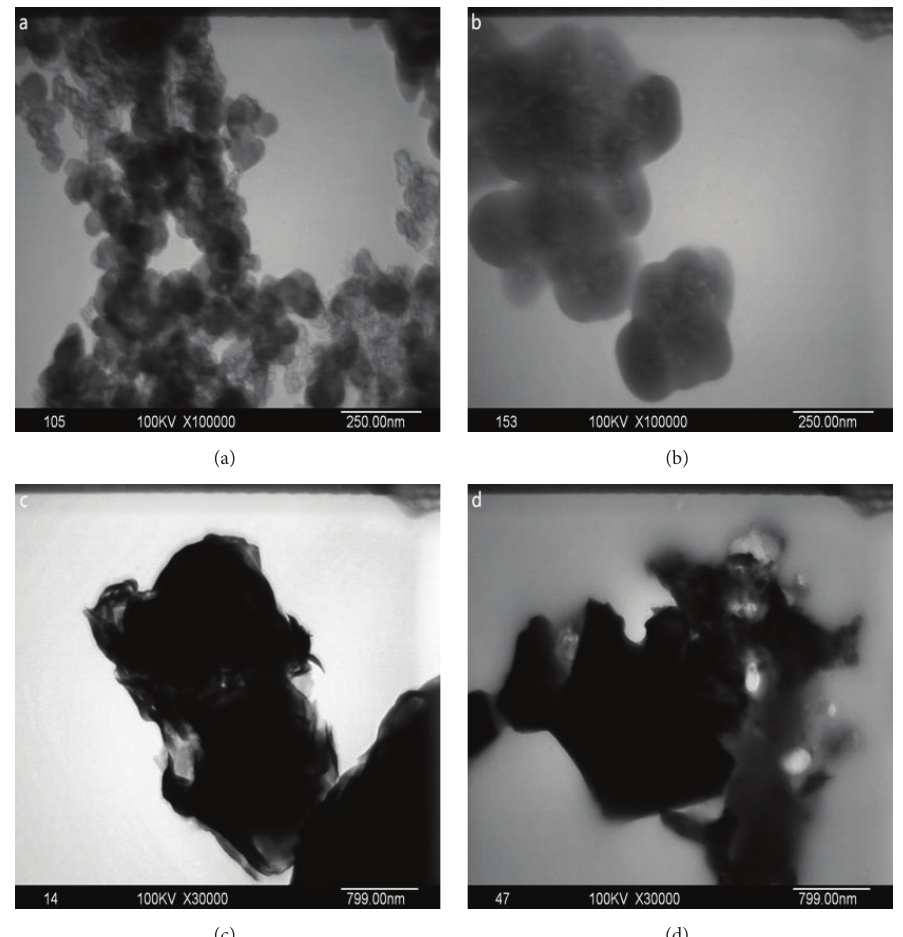
Figure 6: Representative TEM images of different adsorbents. (a) CB (scale bar is 250 nm), (b) OCB (scale bar is 250 nm), (c) bentonite (scale bar is 799 nm), and (d) organic bentonite (scale bar is 799